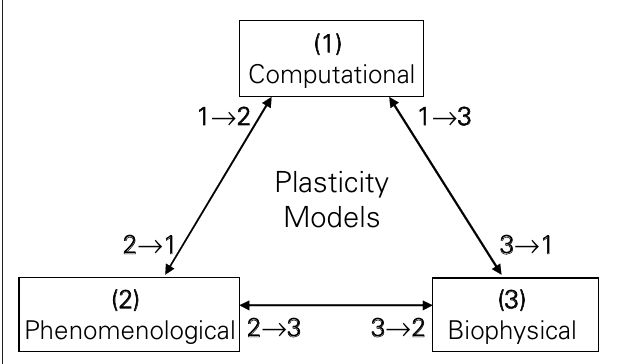
FigurE 1 | Common motivations for plasticity models. The numbers denote affiliation of a model with respect to the three basic motivations, i.e., a model classified as 2 → 1 would be mostly phenomenologically based, but with some computational features. This classification is employed for the taxonomy of the models in Table 3.